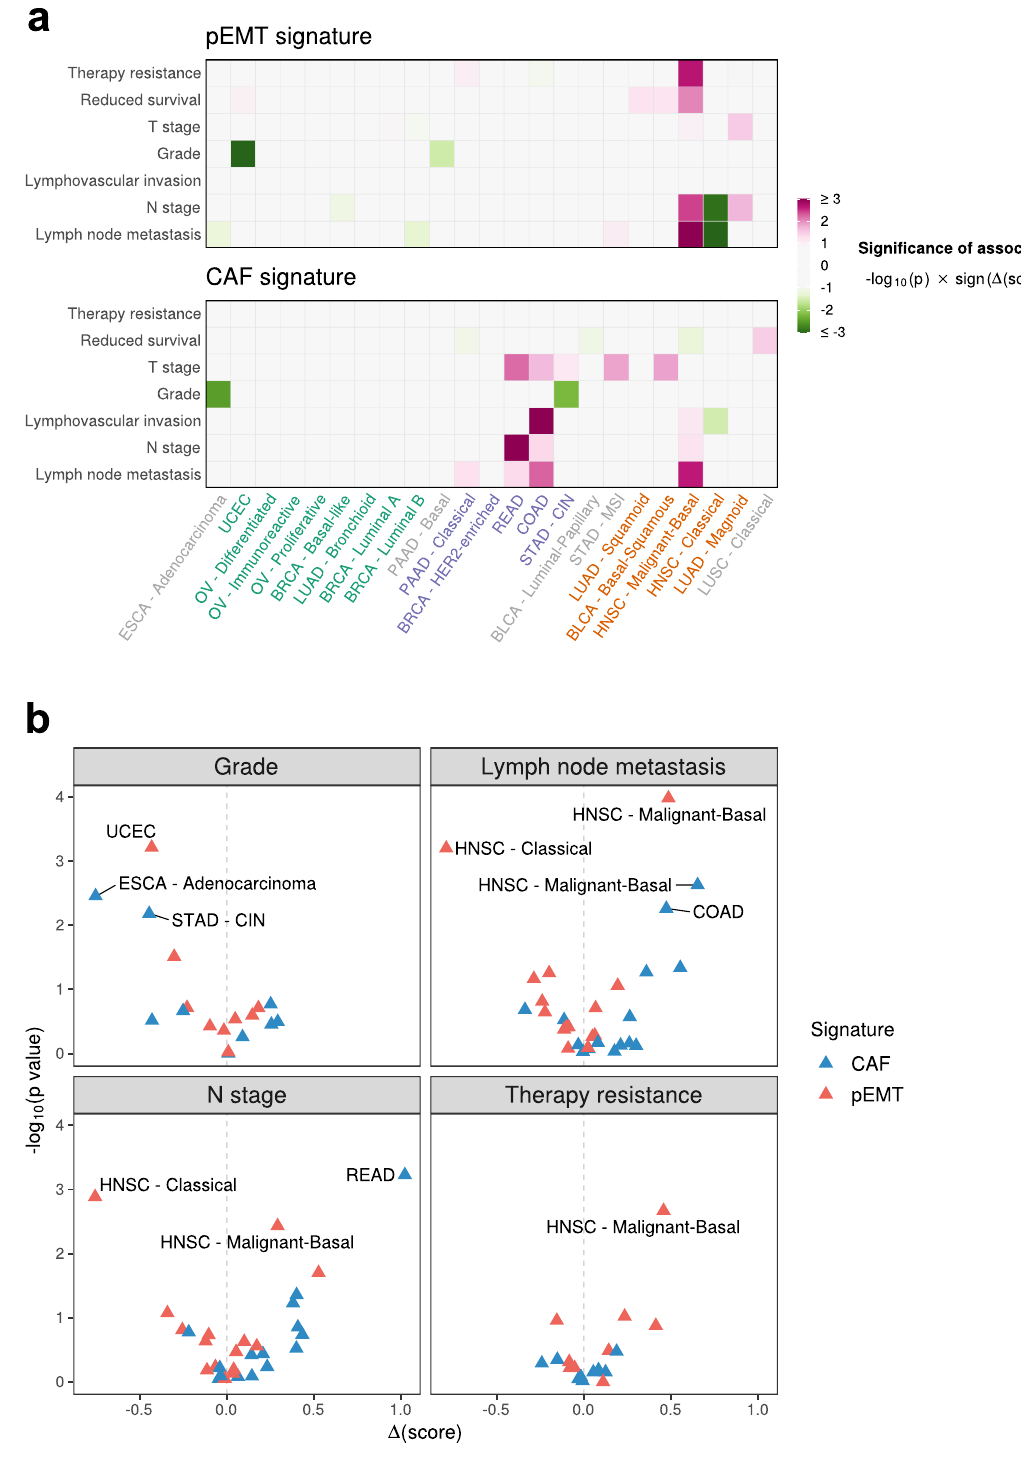
Fig. 5 Association of pEMT and CAF signatures with clinical features. a Heatmaps showing the signi fi cance (quanti fi ed as – log10(p-value) based on a two-sided Wilcoxon rank-sum test, without adjustment for multiple comparisons) of the association of signatures for pEMT (top) and CAFs (bottom) with seven clinical features (rows) re fl ecting worse prognosis, in 23 of the 24 cancer types (columns) passing quality control (the LUSC Secretory subtype is absent due to low sample size). Positive and negative associations are depicted in purple and green, respectively. The cancer types are ordered by hierarchical clustering of their pEMT-CAF scores, and coloured by their pEMT cluster assignments. b Volcano plots showing, for each of four clinical features, the signi fi cance (Y-axis, de fi ned as in a ) of its association with pEMT signatures (red) and with CAF signatures (blue) against the effect size (X- axis, quanti fi ed as the difference in signature score). Points are labelled with their corresponding cancer types if they pass an adjusted signi fi cance threshold corresponding to an FDR of 0.05. Source data are provided as a Source Data fi